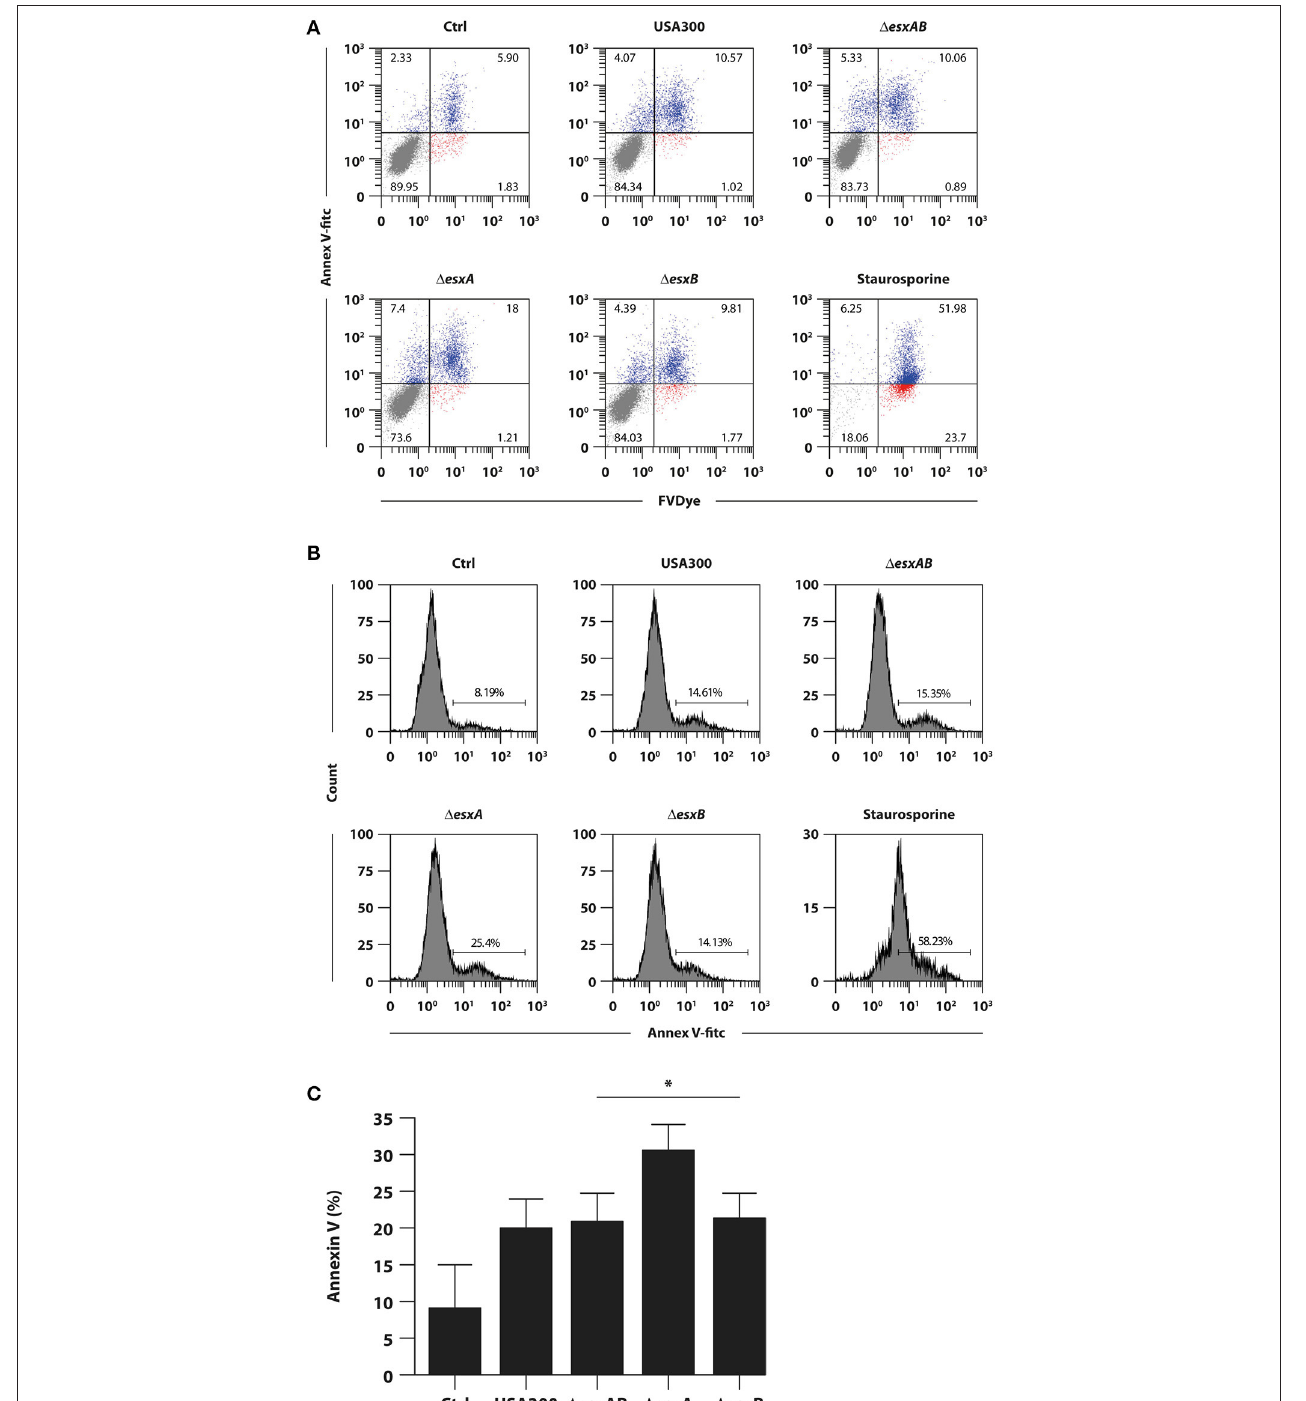
FIGURE 3 | Impact of wild type USA300 and esx mutants on DC apoptosis. DC were left untreated (Ctrl) or infected for 24 h with wild type USA300 or 1 esxAB , 1 esxA, and 1 esxB recombinants . (A) Apoptosis was assessed by cytofluorimetric analysis through Annexin-V and FvDye staining. As internal control DC were treated with 1 µ M staurosporine for 16 h. A representative experiment, out of 3 independent experiments performed that yielded similar results, is shown. Numbers in the dot plots correspond to the percentage of cells in each quadrant. (B) The expression of Annexin-V for the different experimental conditions was reported as the histogram of fluorescence intensity. Numbers in each panel correspond to the percentage of total Annexin-V positive cells. (C) Histogram of the means of Annexin-V positive cell percentage ± SEM of 3 independent experiments. Statistical significance was calculated by Student’s t- test for paired data. * P = 0.004 (wild type USA300- vs. 1 esxA recombinant-infected DC). Statistics refers to strains at the extremity of the horizontal lines.